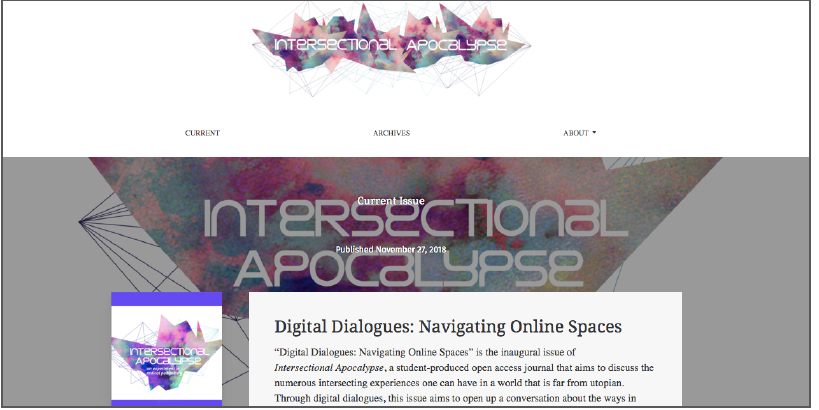
FIGURE 1: A SCREEN CAPTURE FROM THE OPENING PAGE OF THE JOURNAL, WHICH THE STUDENTS COLLECTIVELY DEVELOPED ON OJS, TITLED INTERSECTIONAL APOCALYPSE. AVAILABLE ONLINE